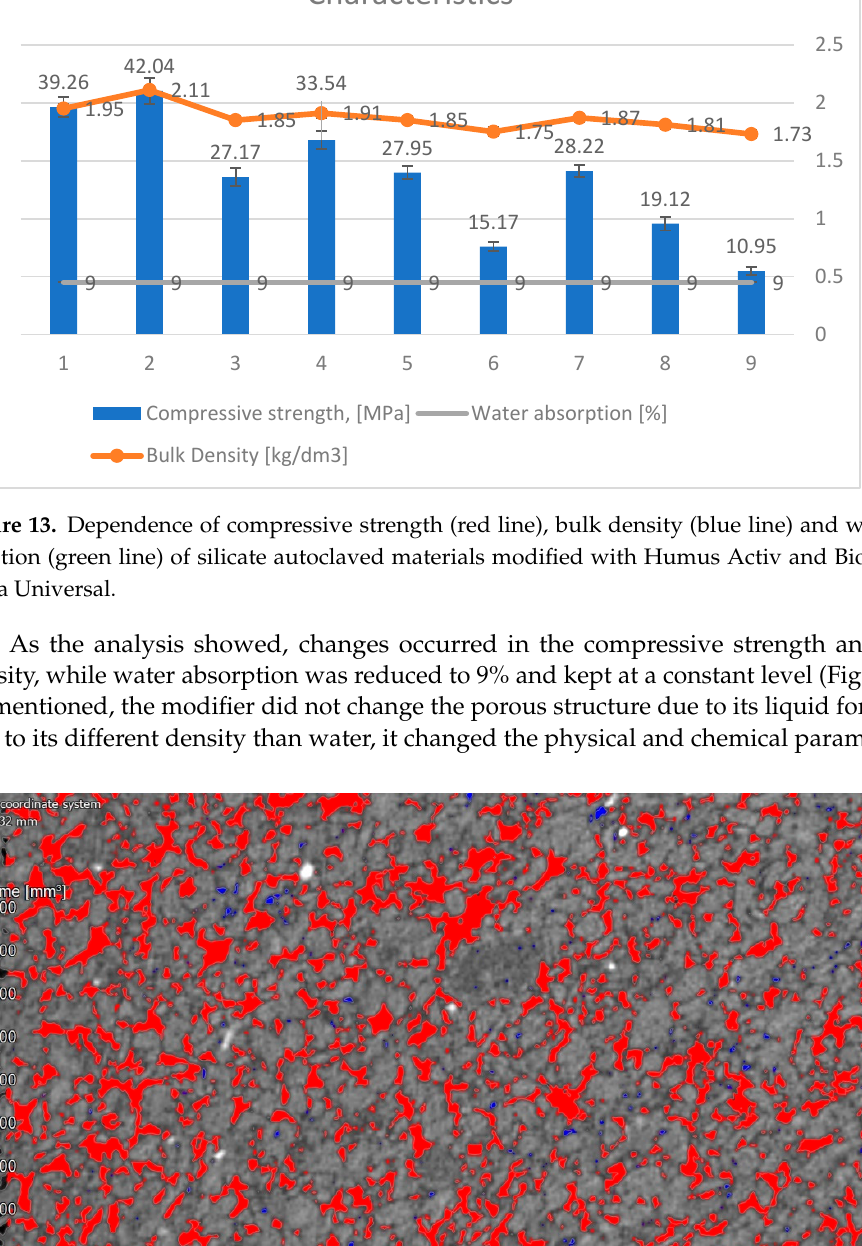
14 of 22 Figure 12. Study of the absorption caused by capillary rising of modified sand–lime products. All samples with the modifier admixed absorbed water evenly and gradually (the samples were placed in a vessel with water with the facing surface). Modified silicate ele-